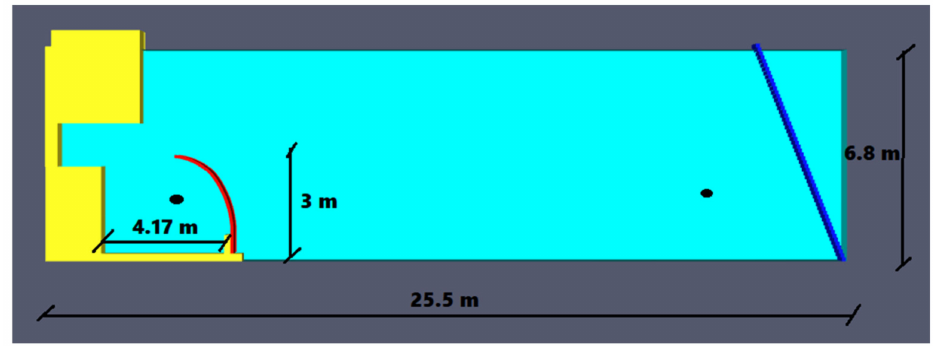
Figure 6. The slice model: dimensions and control point (in